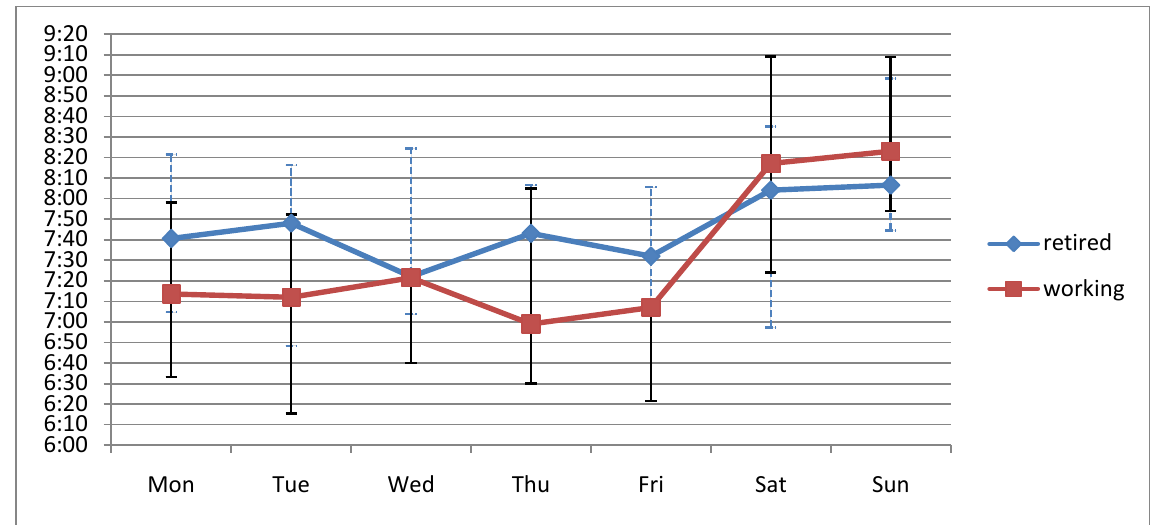
Figure 1. Median intake times of the morning doses in retired (N = 41) and working (N = 30) patients. Whiskers indicate the 1st and 3rd quartiles,